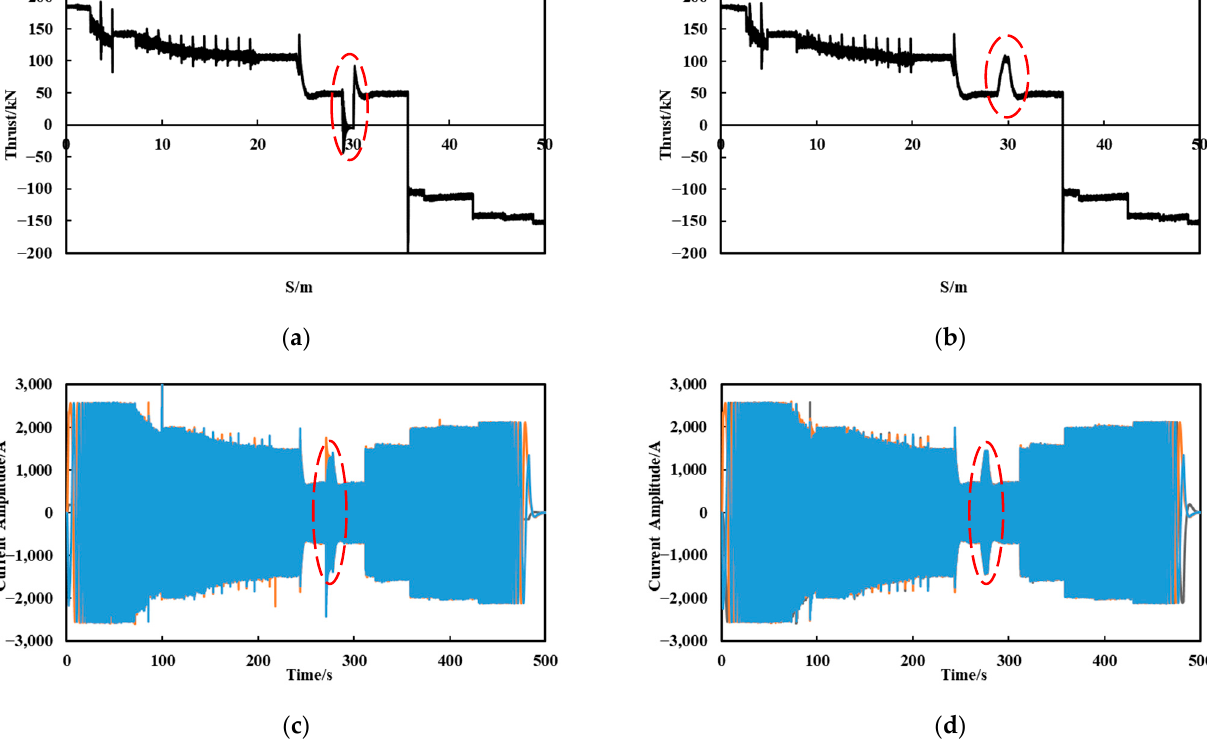
Figure 14. The current and thrust force of LLSM at two sides when the fault occurs during constant speed: ( a ) thrust of the fault side LLSM; ( b ) thrust of the normal side LLSM; ( c ) current of the fault side stator segment; ( d ) current of the normal side stator segment.